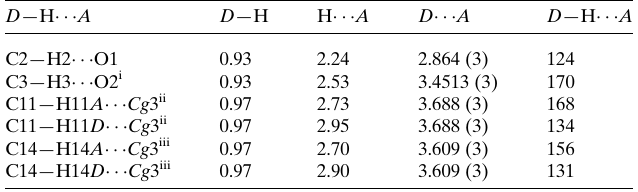
Figure 1 The molecular structure of the title compound, with the atom labelling and displacement ellipsoids drawn at the 50% probability level. H atoms are shown as small circles of arbitrary radii.